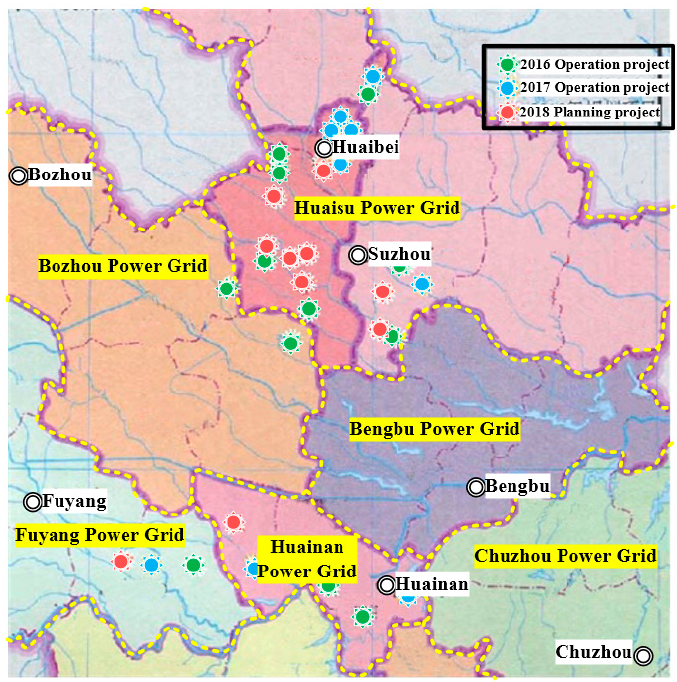
Figure 1. Operation and planning photovoltaic power stations in Anhui power grid. Table 1. Installed power capacities of Huaisu and Huainan power grids. Region